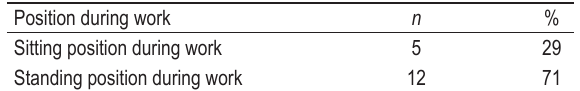
TABLE 7. Standing/sitting position